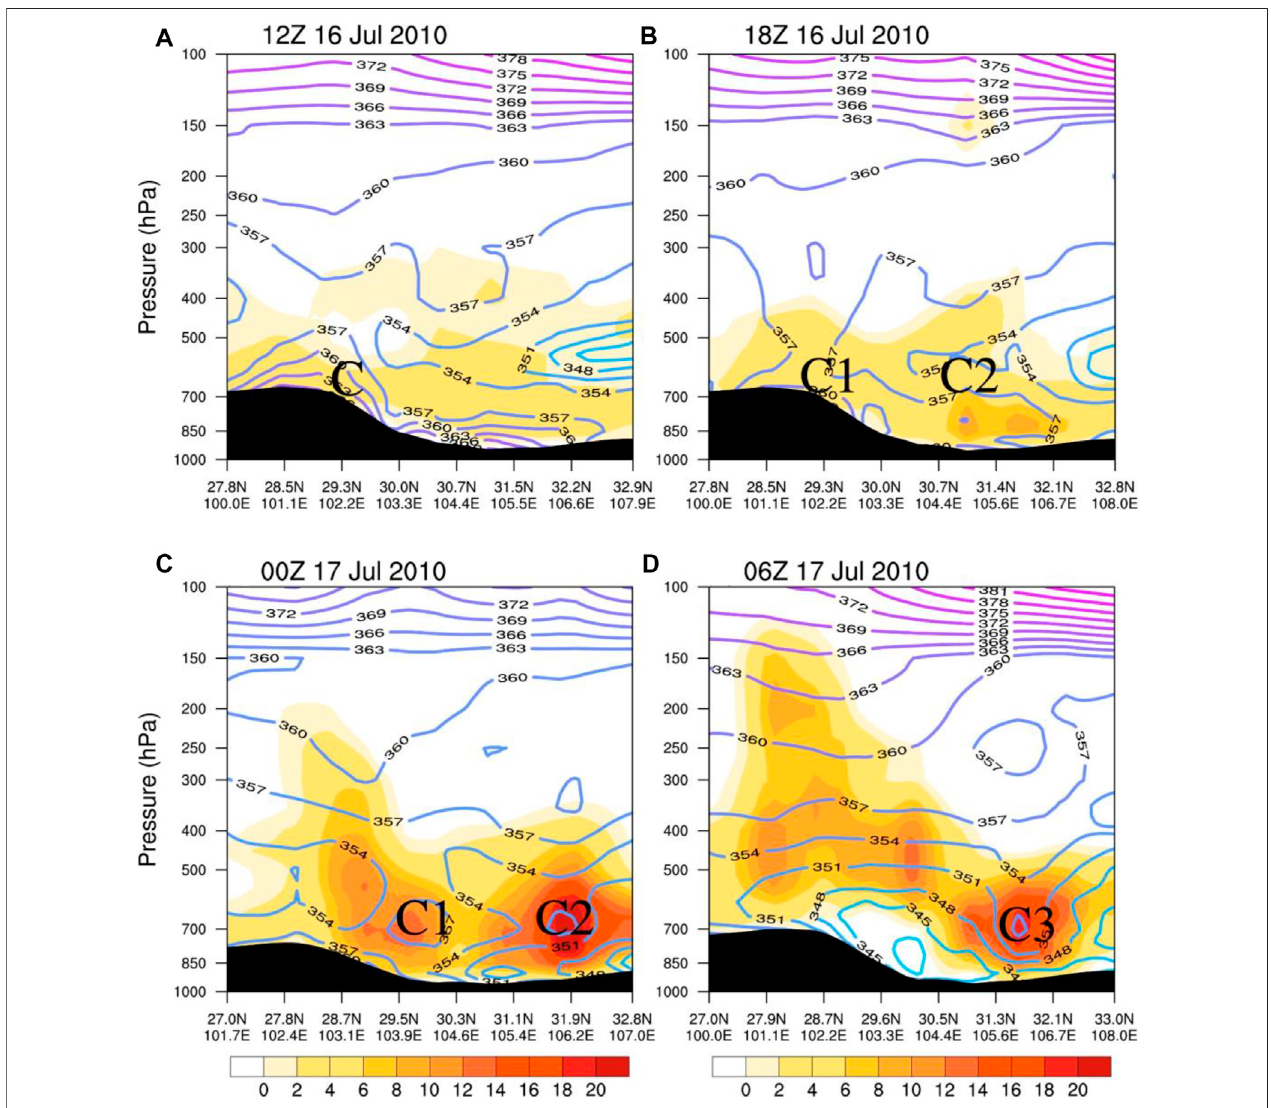
FIGURE 5 | Vertical cross sections of the pseudoequivalent potential temperature (K, contours) and relative vorticity (10 − 5 s − 1 , shaded) at (A) 12:00 UTC July 16, (B) 18:00 UTC July 16, (C) 00:00 UTC July 17, and (D) 06:00 UTC July 17. The black areas at the bottom of the fi gures represent the topography (the same in the following fi